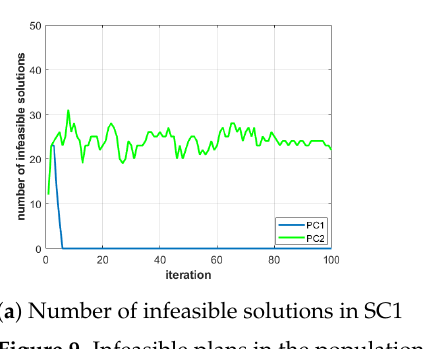
Figure 9. Infeasible plans in the population for PC1 (blue) and PC2 (green) for SC1 ( a ) and SC2 ( b